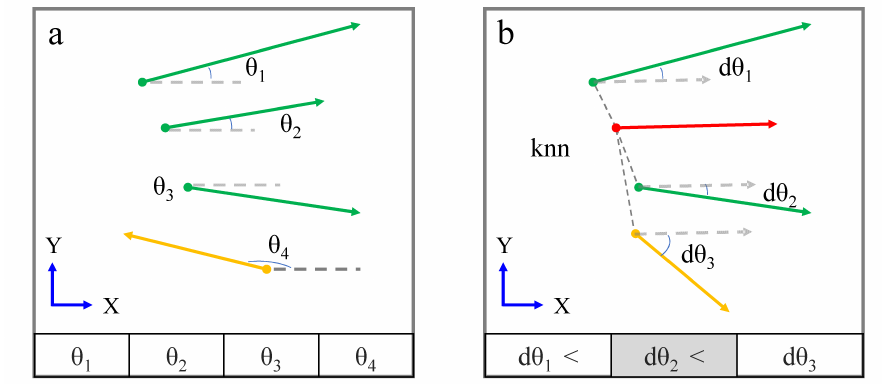
Figure 3. Illustration of the HMCC algorithm